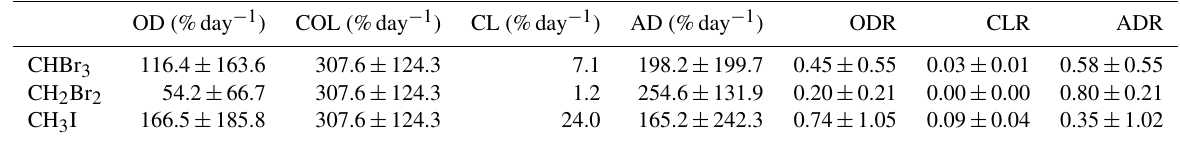
Table 3. Mean ± standard deviation of oceanic delivery (OD), convective loss (COL), chemical loss (CL), advective delivery (AD), oceanic delivery ratio (ODR), chemical loss ratio (CLR) and advective delivery ratio (ADR) for CHBr 3 , CH 2 Br 2 and CH 3 I.